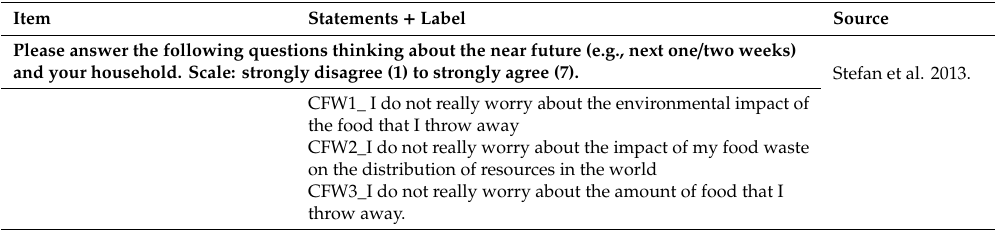
Table A3. Concern about food waste.